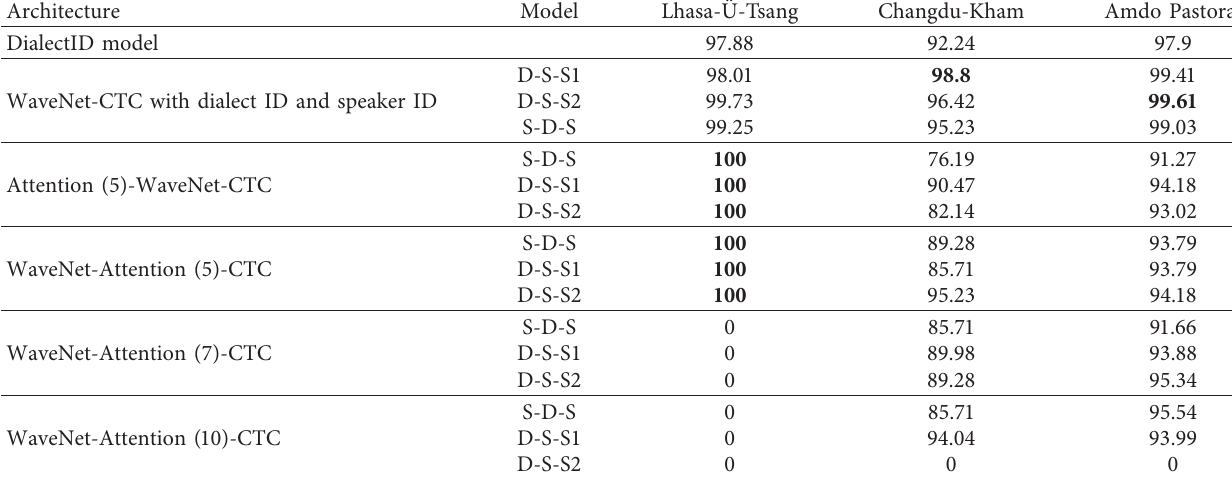
Table 6: Dialect ID recognition accuracy (%) of three-task